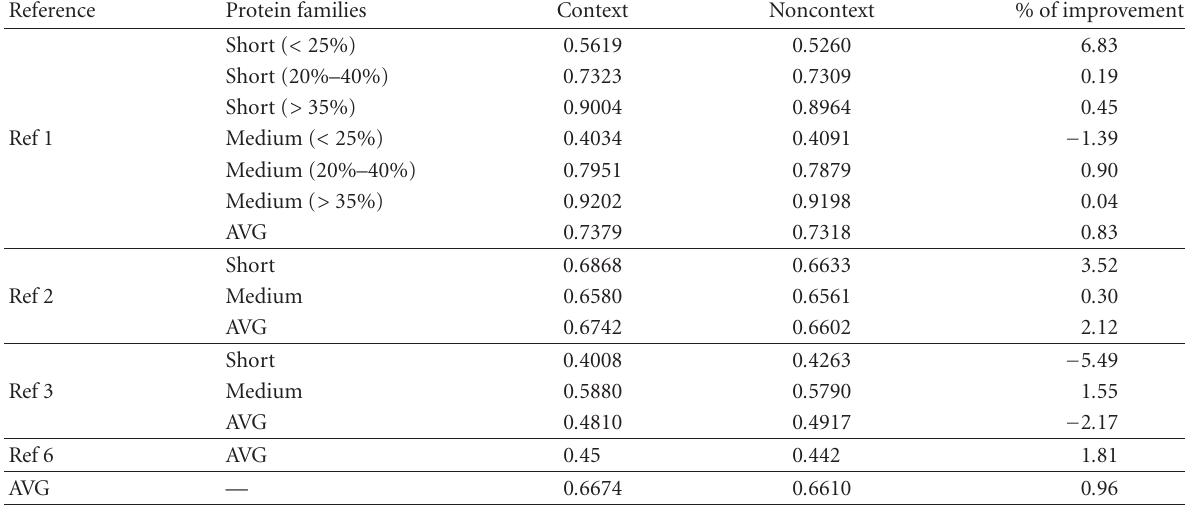
Table 4. Summarized score for contextual versus noncontextual model. Score here corresponds to the frequency of properly aligned pairs of residues.